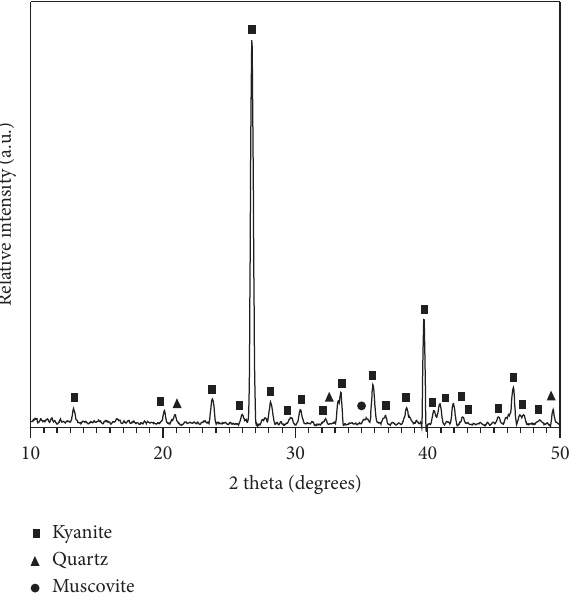
Figure 1: X-ray diffraction pattern of kyanite Table 1: Chemical composition of kyanite raw and kyanite-aluminum mix (%).